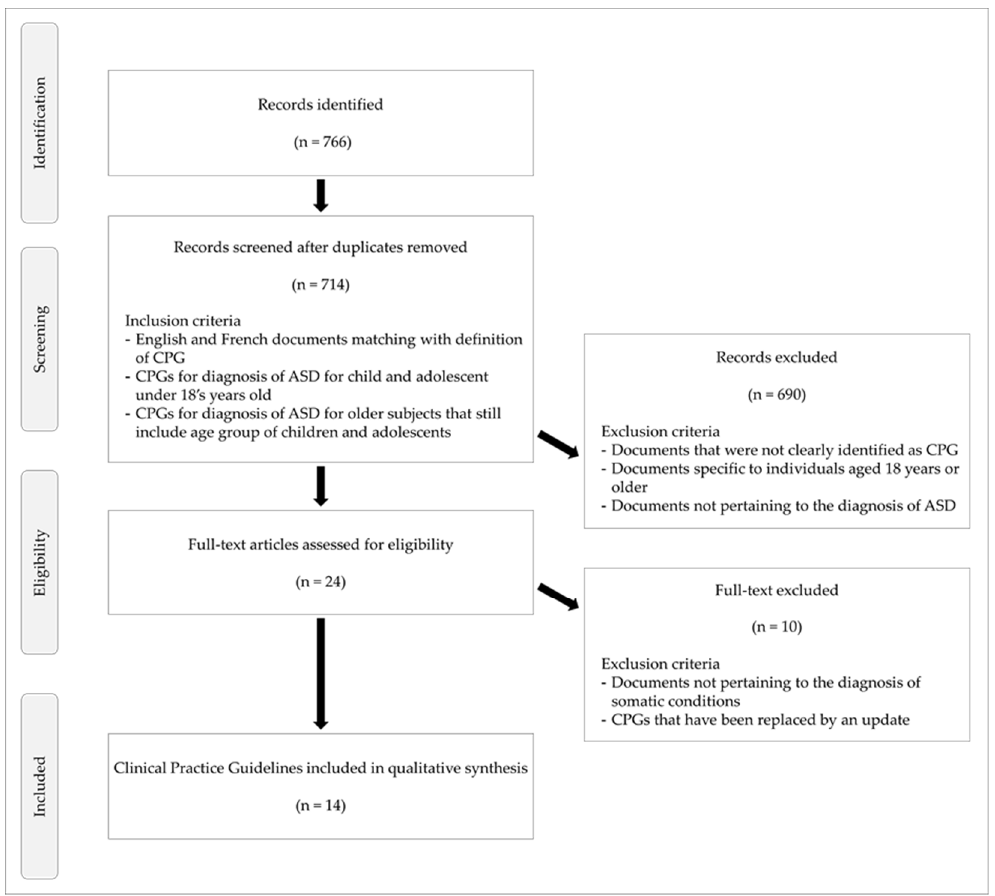
Figure 1. CPGs’ selection flow diagram.